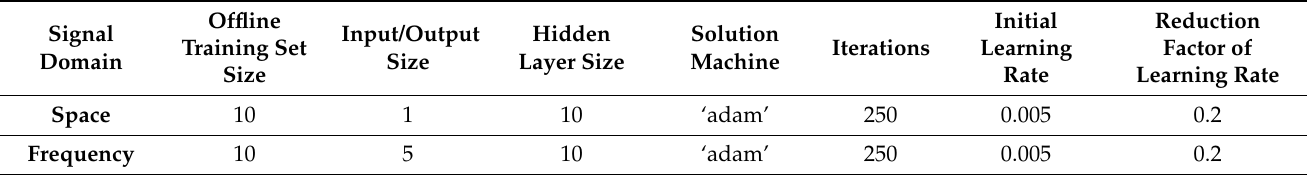
Table 3. Parameter setting of the LSTM-based interference activity prediction model.